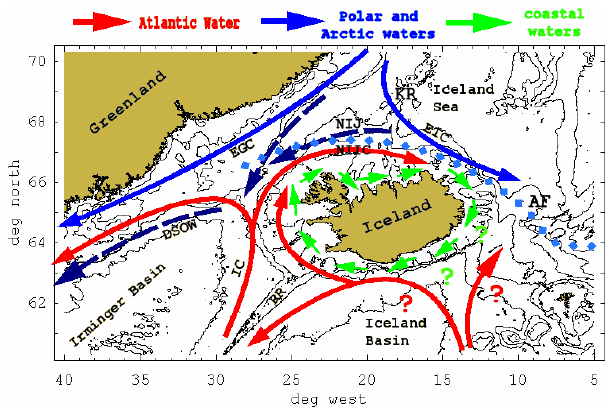
Fig. 1. Bathymetry around Iceland and the classical view of the ocean circulation. The isobaths are: 200, 500, 1000, 2000 and 3000 meters. The abbreviations are: AF – Arctic Front, DSOW – Den- mark Strait Overflow Water, EGC – East Greenland Current, EIC – East Icelandic Current, IC – Irminger Current, KR – Kolbein- sey Ridge, NIIC – North Icelandic Irminger Current, NIJ – North Icelandic Jet, RR – Reykjanes Ridge. The question marks indicate questionable structures like the coastal current. Modified after Lo- gemann and Harms